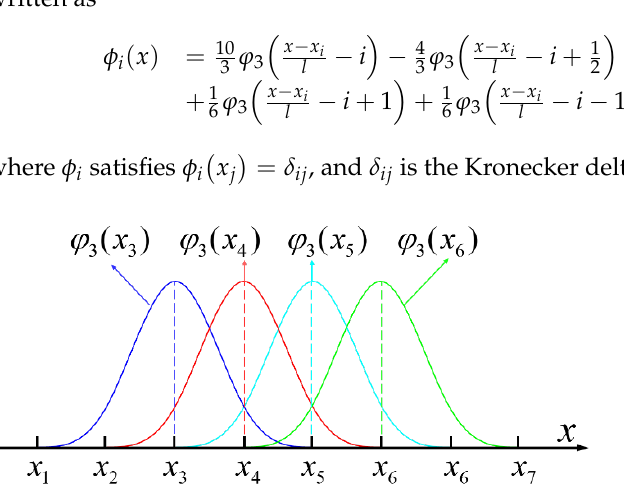
Figure 4. Basic function constructed by cubic B-spline function.